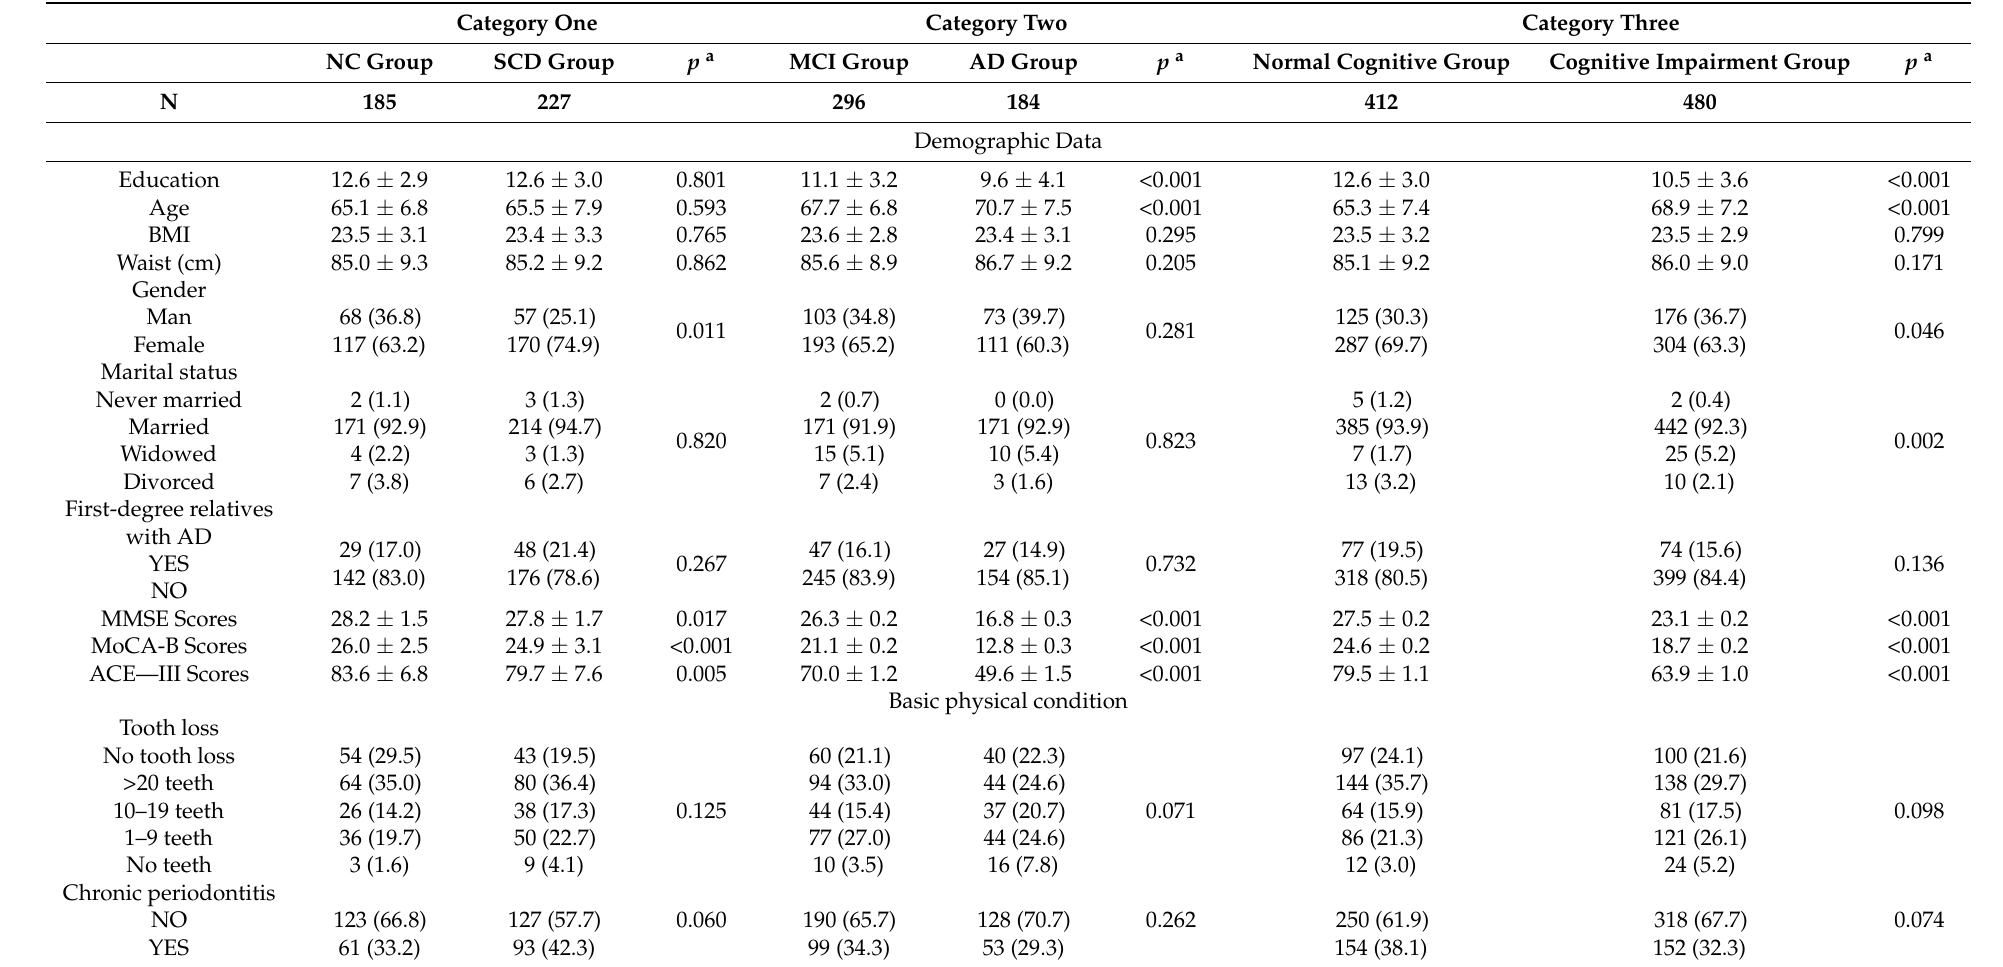
Table 1. Description of the study sample based on cognitive